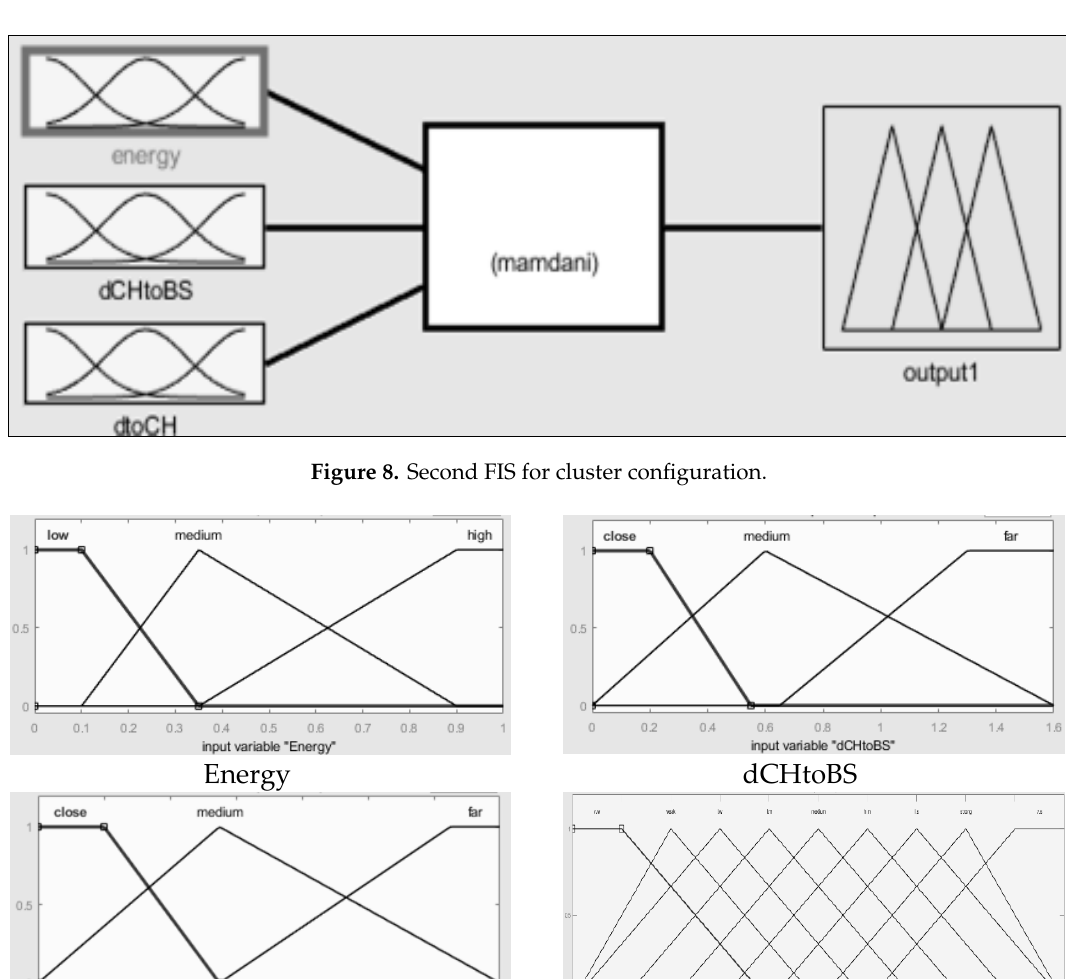
Figure 7. Flowchart of the cluster head selection process.